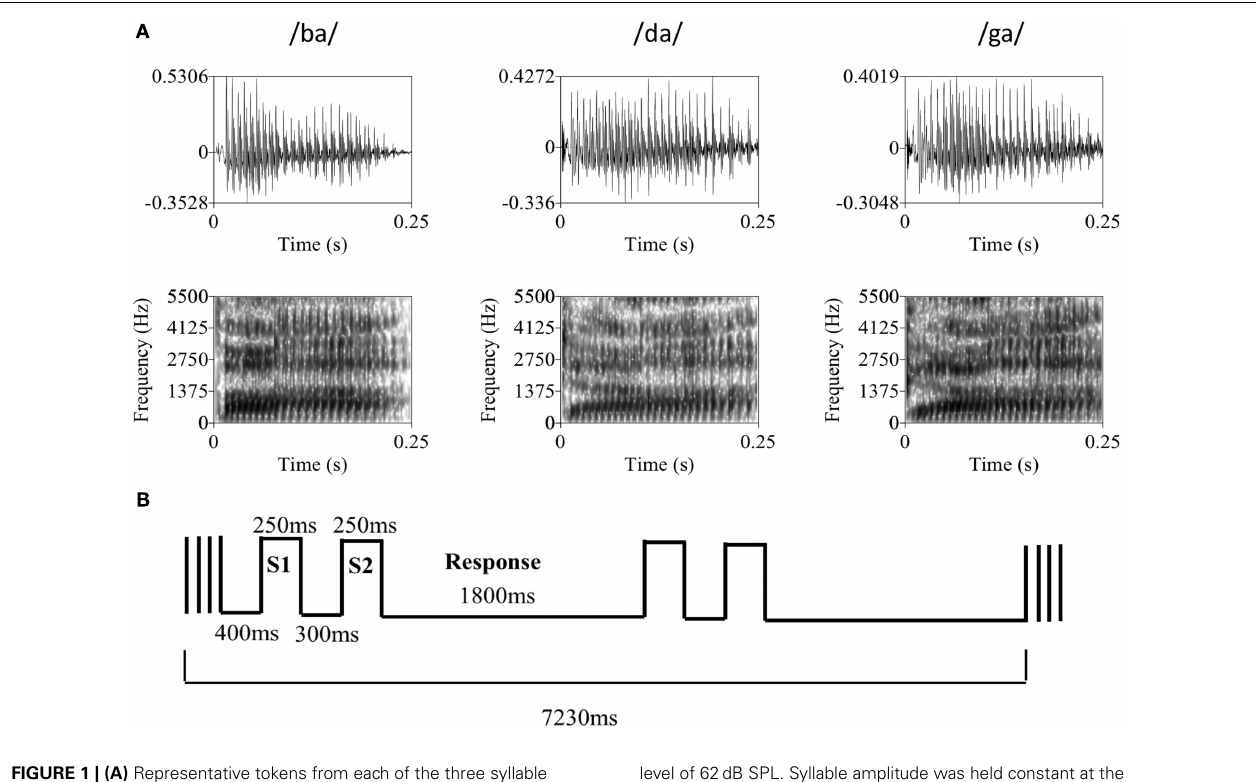
FIGURE 1 | (A) Representative tokens from each of the three syllable categories used in the discrimination task.The top row contains the raw waveforms for each token with amplitude ( y -axis) plotted against time ( x -axis).The bottom row contains the associated spectrograms for each token with frequency in Hz ( y -axis) plotted against time ( x -axis), where darker sections indicate greater sound energy. During the experiment, auditory syllable stimuli were presented in broadband Gaussian noise at a constant